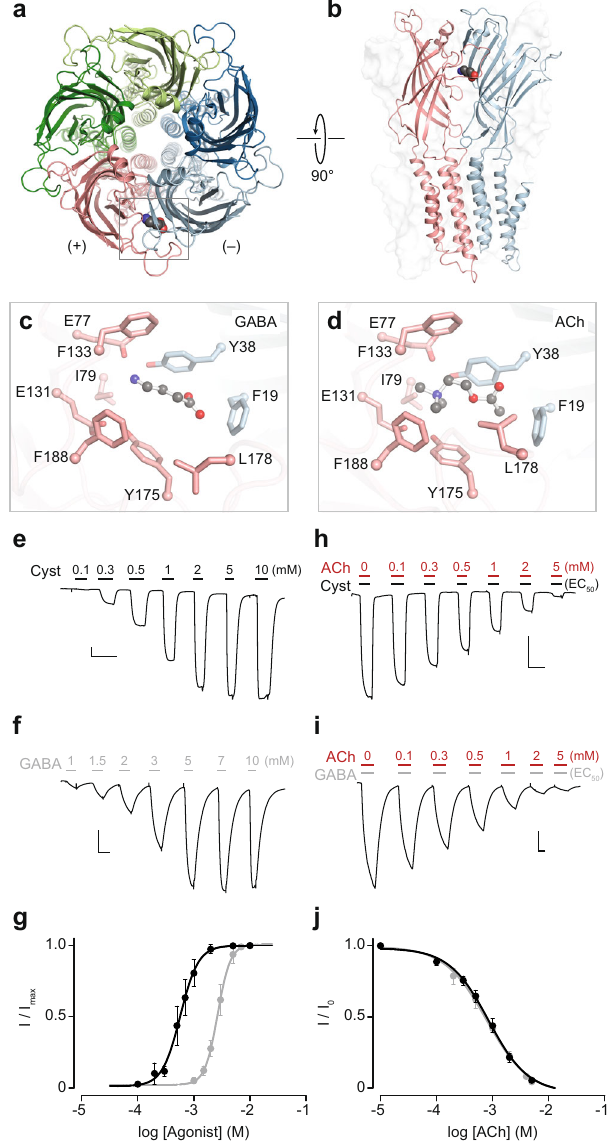
Fig. 1 ACh binds to the agonist-binding site of ELIC and competitively inhibits agonist activated currents. a , b Crystal structure (PDB ID: 2YOE) 9 of ELIC in complex with the agonist GABA (spheres), where each of the fi ve identical subunits are shown in a cartoon representation. Box indicates a single agonist-binding site at the interface between two subunits. Close-up views of the agonist binding site in complex with c GABA (PDB ID: 2YOE) 9 and d ACh (PDB ID: 3RQW) 10 , with residues on the principal face ( + ; pink) and complementary face ( – ; cyan) highlighted as sticks. Ligands are shown as ball and sticks. Representative whole-cell traces for e cysteamine-activated (Cyst) and f GABA- activated ELIC, along with g the associated dose response curves for cysteamine (black circles) and GABA (gray circles). Representative whole-cell traces for ACh-inhibited ELIC activated by an EC 50 concentration of h cysteamine (0.6mM) or ( i ) GABA (2.7mM), as well as j the dose response curve for ACh inhibition in the presence of either cysteamine (black circles) or GABA (gray circles) at their respective EC 50 . Agonist ( e , f ) and antagonist concentrations ( h , i ), both in mM, are indicated above each peak with the duration of application shown as black, gray, and red bars for cysteamine, GABA, and ACh, respectively. In ( e , f , h , i ) the x - and y -axis of each scale bar corresponds to 1min and 0.5 µ A, respectively. Error bars in the dose response curves represent one standard deviation from the mean, obtained from a minimum of 5 independent oocyte